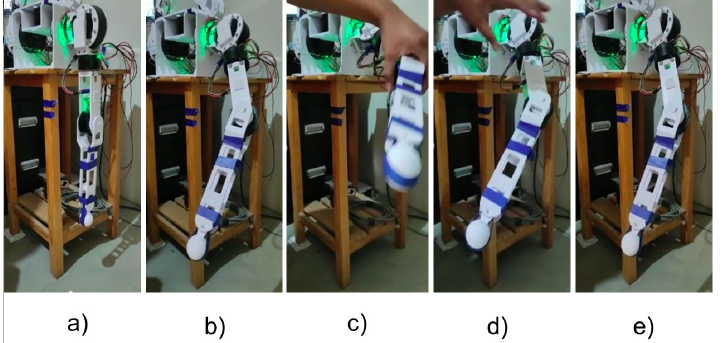
Figure 21. Frame of Left Arm positioned at [ − 30 ◦ ; 30 ◦ ; 60 ◦ ; 30 ◦ ]. ( a ) ZERO position; ( b ) desired posi- tion; ( c ) applying an external disturbance; ( d ) post-disturbance position regulation; ( e ) final position.